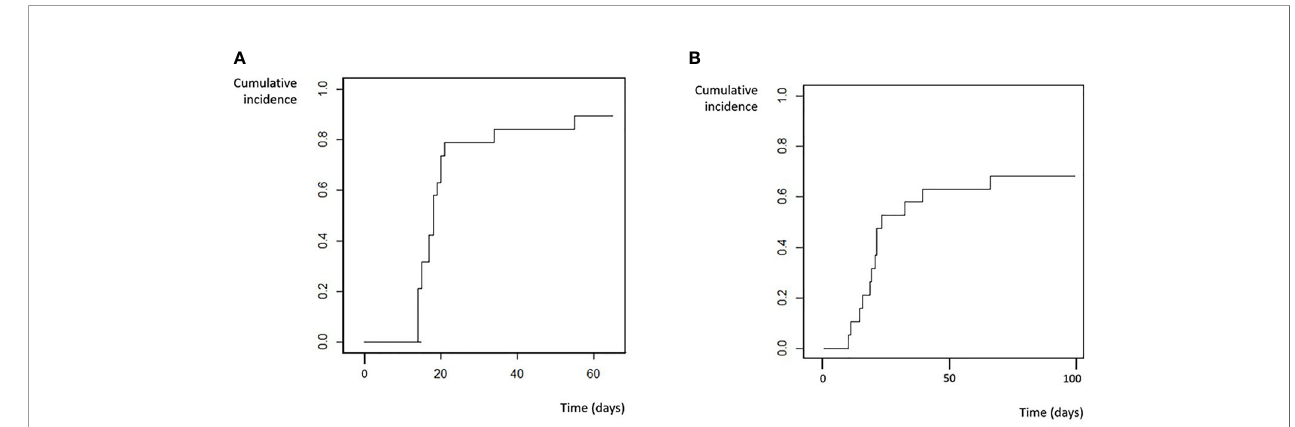
FIGURE 1 | Engraftment. (A) Neutrophil. (B)